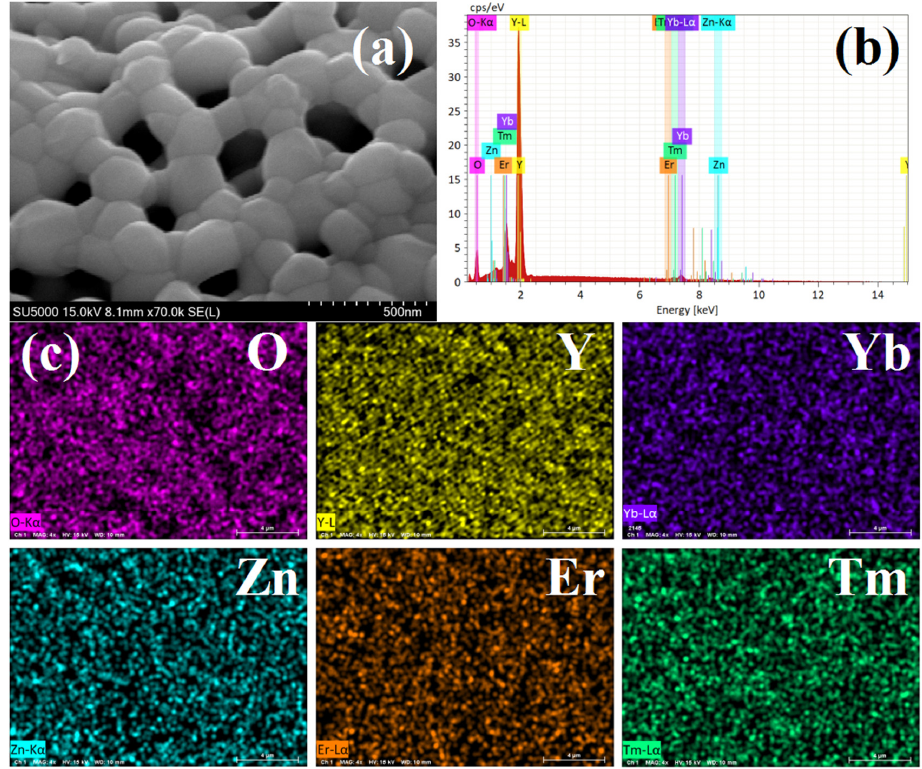
Figure 1. ( a ) SEM morphology (Er 3+ : 1 mol%) ( b ) EDS spectrogram of representative Y 2 O 3 - ZnO:Yb 3+ /Er 3+ /Tm 3+ nano-phosphor (Er 3+ : 1 mol%) ( c ) EDS mapping for each